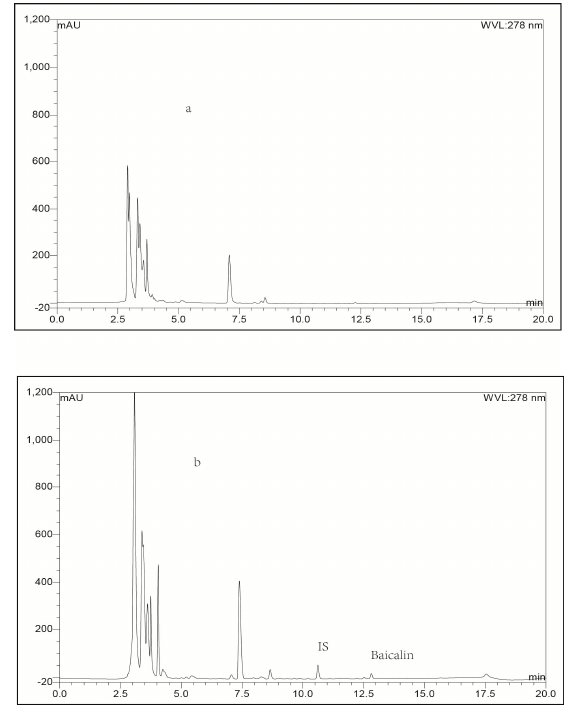
Figure 7. Representative LC-UV chromatograms obtained for blank kidney tissue ( a ) and kidney bio-sample collected from a rabbit at 0.25 h after intravenous administration of baicalin-loaded liposomes at a dose of 10 mg/kg + IS ( b ).